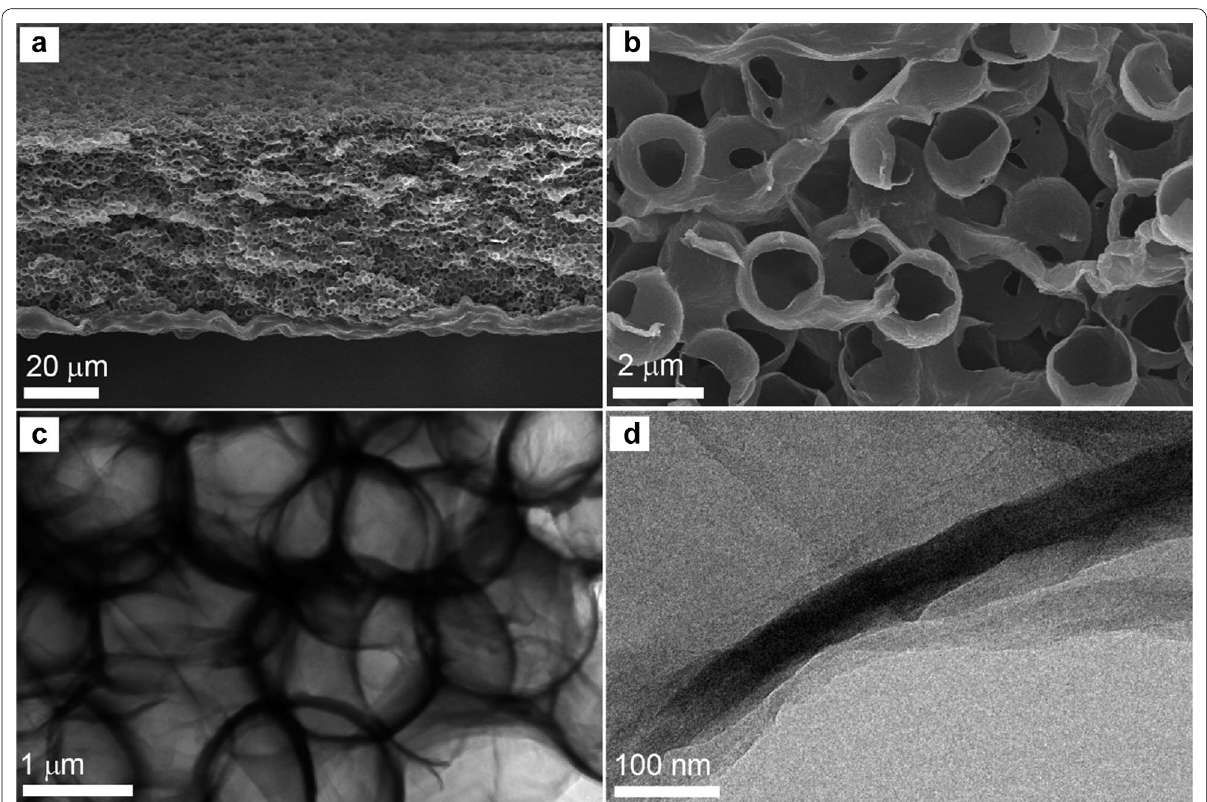
Fig. 4 a Low‑magnified and b high‑magnified cross‑sectional SEM images of the macroporous chemically modified graphene film. c , d TEM images of the macroporous chemically modified graphene film (Reprinted with permission